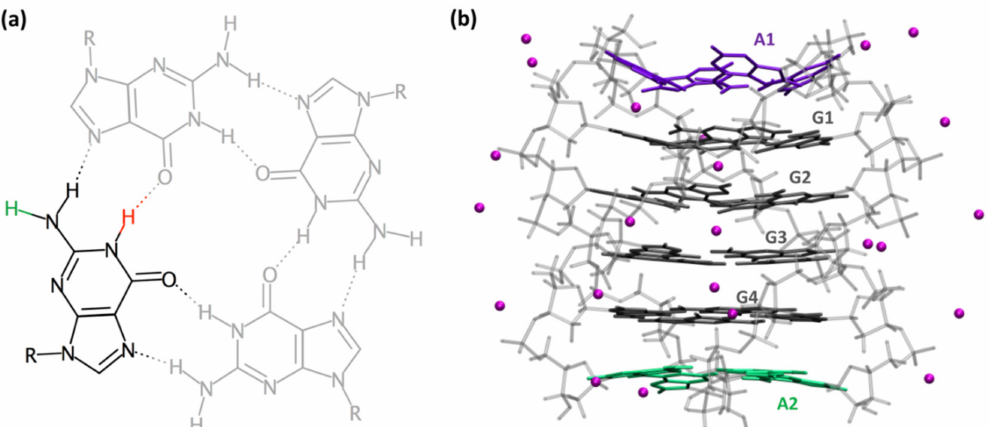
Figure 1. Schematic representation of a G-tetrad ( a ) and the (AG 4 A) 4 /K + G-Quadruplex ( b ). Transfer of the red or green proton ( a ) to the aqueous solvent, concerning the guanine radical cation, gives rise to deprotonated radicals (G-H1) • or (G-H2) • , respectively. In ( b ), guanines are depicted in gray (tetrads labelled as G1, G2, G3, G4), adenines in violet (at 5 (cid:48) , A1) and green (at 3 (cid:48) , A2); the backbone is shown in light grey and ions are represented by pink